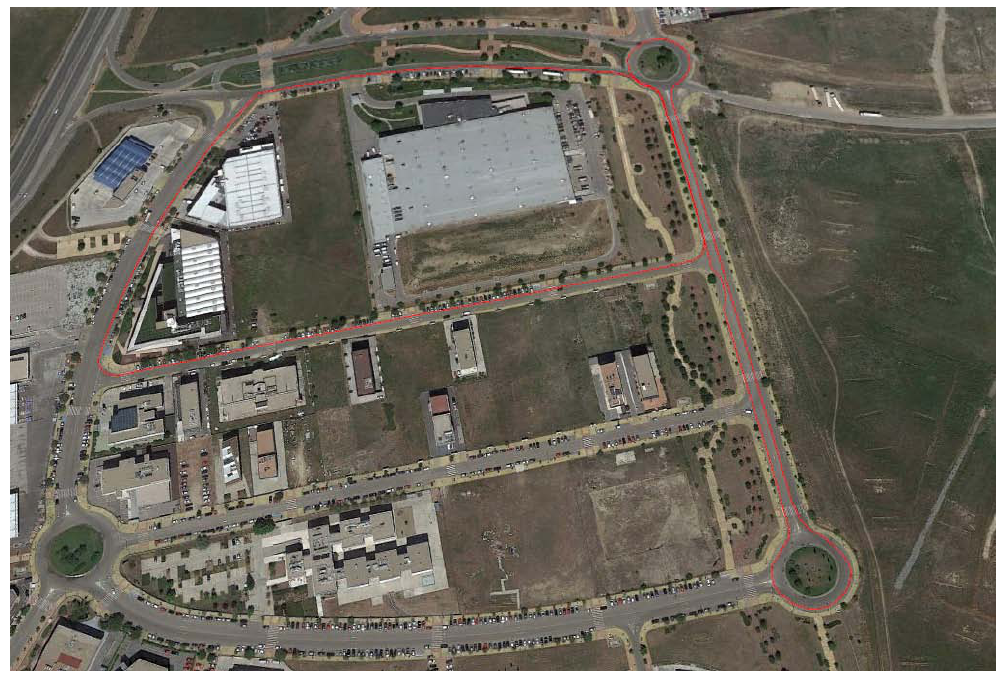
Figure 14. Test 3: Map and vehicle trajectory (Map scale 1:5036 cm).